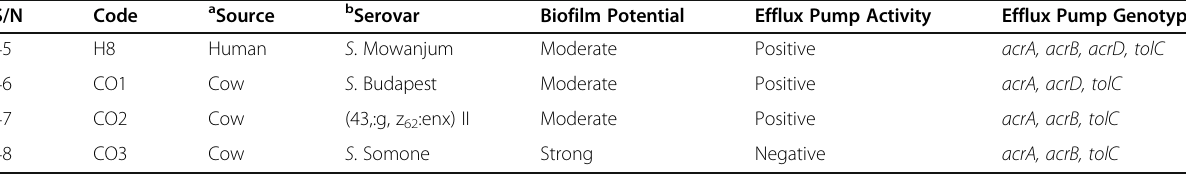
Table 3 Source of Salmonella Serovars, their Biofilm Forming Potential, Efflux Pump Activity and Efflux Pump Genotype (Continued)